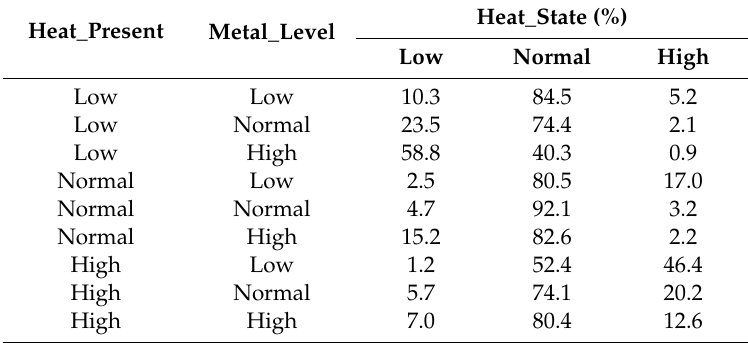
Table 2. Conditional probability distribution of “Heat_present” and “Metal_level” to “Heat_state”. Heat_State (%) Heat_Present Metal_Level Low Normal High Low Low Low Normal Low High